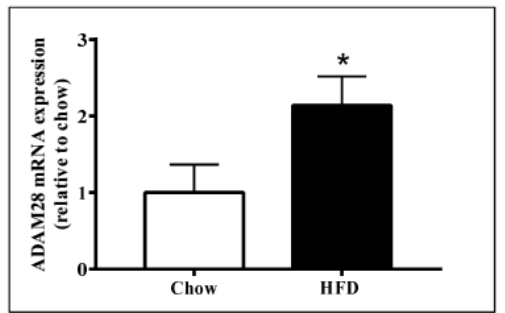
Figure 2. Increased A Disintegrin And Metalloproteinase 28 (ADAM28) mRNA expression in livers of mice fed a high fat diet (HFD). Expression of ADAM28 mRNA in livers from mice fed either a normal chow or high fat diet. * p < 0.05; n = 12–14.